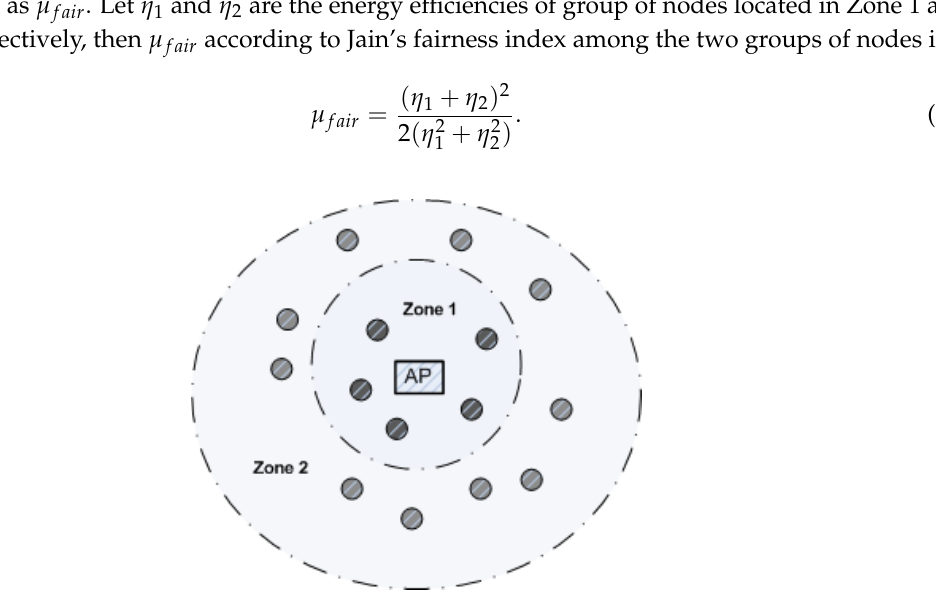
Figure 7. Wireless local area networks (WLANs) division in various zones depending on their respective distances from AP.